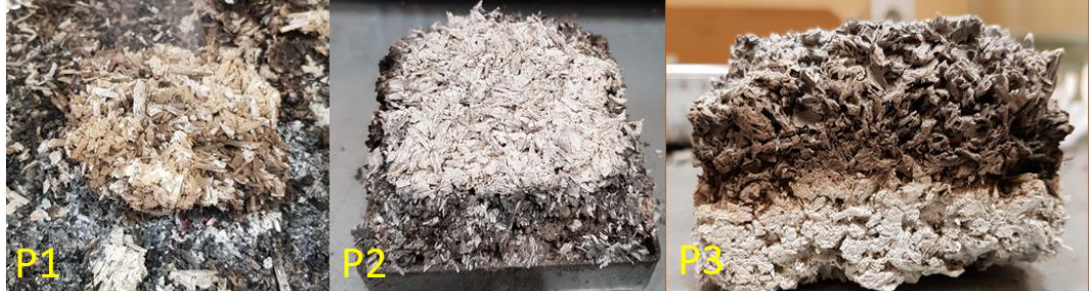
Figure 3. Samples after exposure to heat in the cone calorimeter test. Time to sustained flaming is provided in Figure 4. Time to ignition increases from 14 to 19 s for BAC with BG, while with PG this time is from 15 to 19 s. Higher initial water content after conditioning of the samples did not affect the time to ignition significantly.